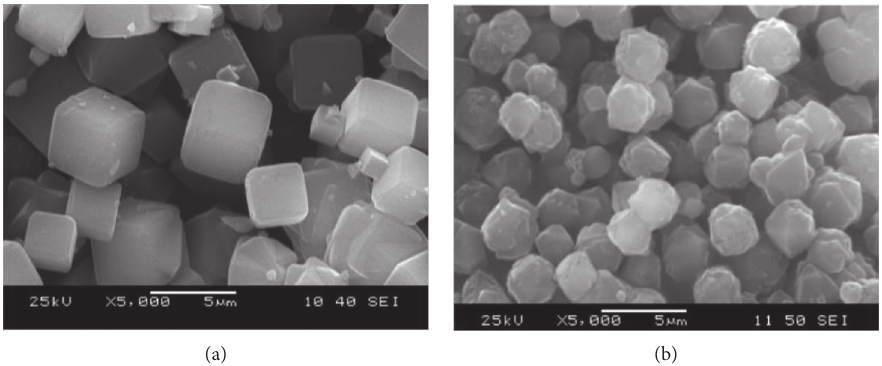
Figure 4: SEM images of synthetic (a) zeolite A and (b) zeolite X adopted from